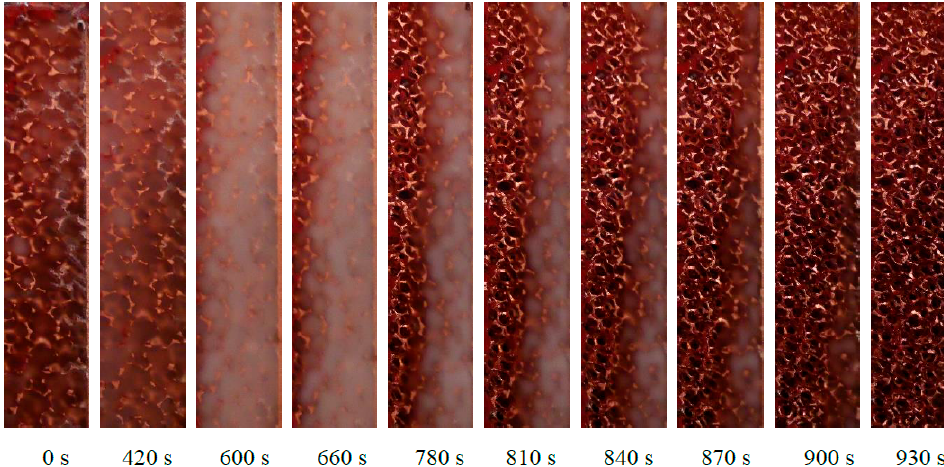
Figure 4. Melting front of the paraffin RT42 inside the 10 PPI copper foam with a porosity of 0.933 with an imposed heat flux of 10 kW m − 2 .